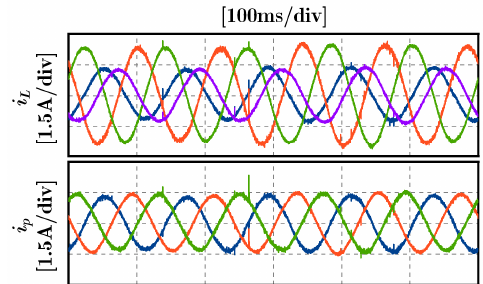
Figure 15. Phase current reconstruction under 100 r/min.